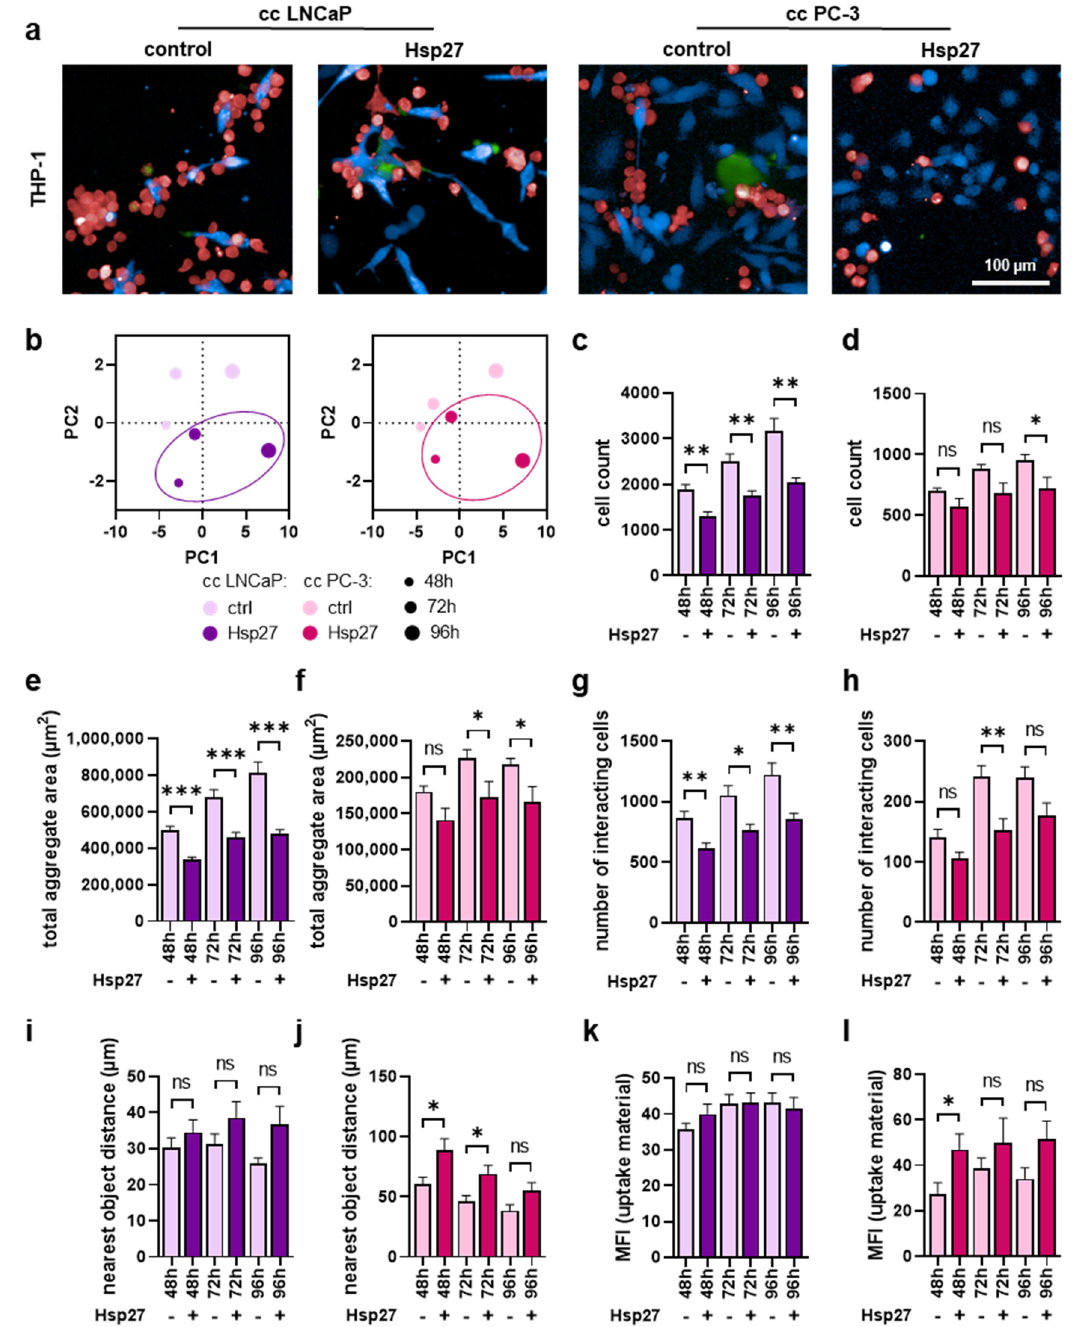
Figure 4. High-content imaging of THP-1 cells co-cultured with prostate cancer cells under Hsp27 treatment. ( a ) representative overlay images of untreated (control) and Hsp27-treated co-cultures (cc) of CellTrace Violet-labeled prostate cancer cells (blue) and CellTrace Far Red-labeled THP-1 cells (red), with SYTOX Green (green) as dead cell marker at 96 h; ( b ) PCAs of several morphology properties quantified by algorithm-based image analysis of THP-1 cells; ( c – l ) algorithm-based image quantification of THP-1 total cell count ( c , d ), the total aggregate area in µm 2 ( e , f ), number of cells interacting with prostate cancer cells ( g , h ), distance to the nearest prostate cancer cell in µm ( i , j ), and mean fluorescence intensity (MFI) of dead prostate cancer cell material internalized by THP-1 cells ( k , l ). Data are presented as mean + SE. Statistical analysis was performed using unpaired, two-tailed t -test with p < 0.05 (*), p < 0.01 (**), and p < 0.001 (***). ns = not significant. Scale bar is 100 µm.